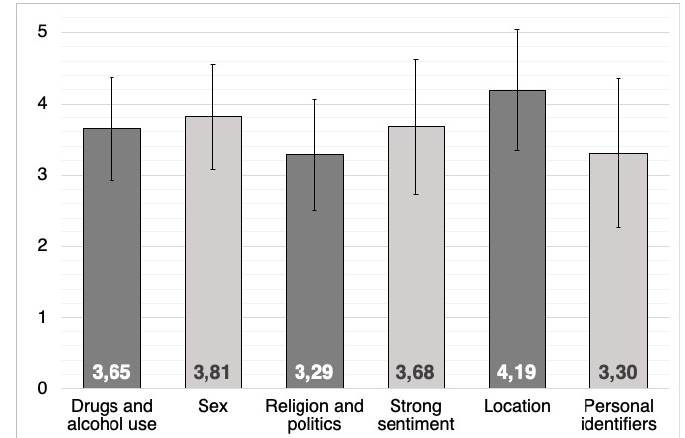
Figure 1. Perceived severity of each category of